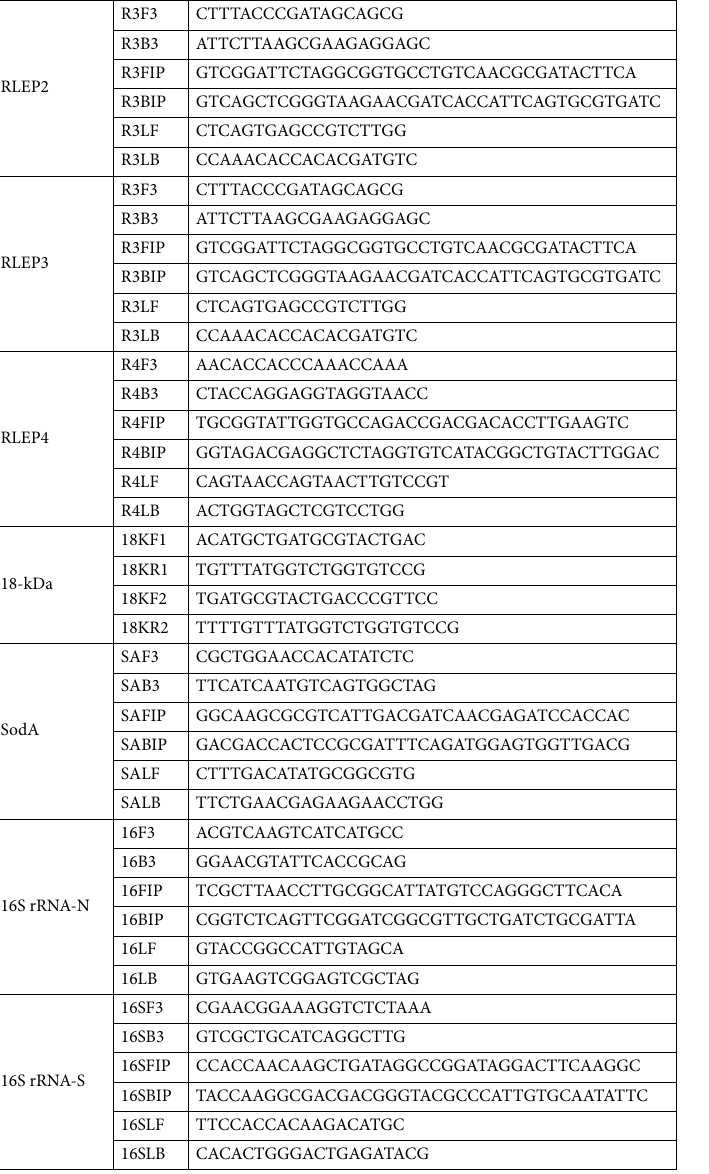
Table 1. List of LAMP primers used for detecting